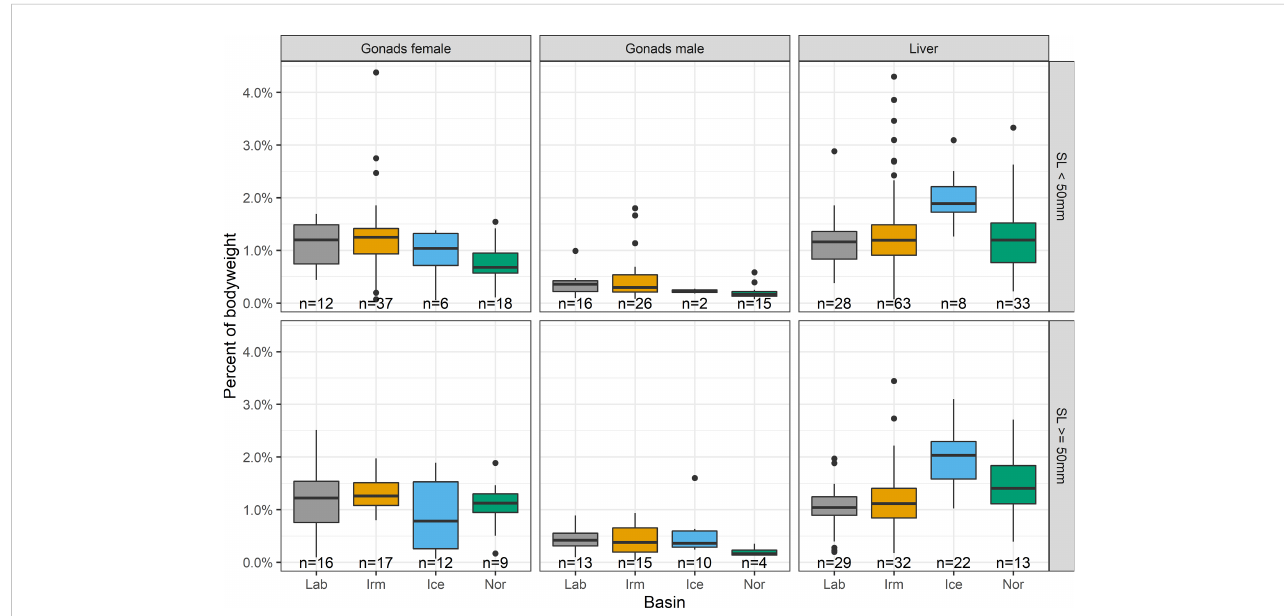
FIGURE 6 Liver and gonad weight indicators (females and males) as percentage of body weight, in the four basins for large (SL ≥ 50 mm) and small (SL< 50 mm) Benthosema glaciale . Basins are shown along the x-axis: Labrador Sea (Lab), Irminger Sea (Irm), Iceland Sea (Ice) and Norwegian Sea (Nor). Boxplot show median (vertical line) 25 and 75% quartile (hinges) and whiskers (~95% con fi dence interval). Data falling outside the whiskers are shown as dots. n refers to the number of fi sh gonads and livers that could be weighed in each